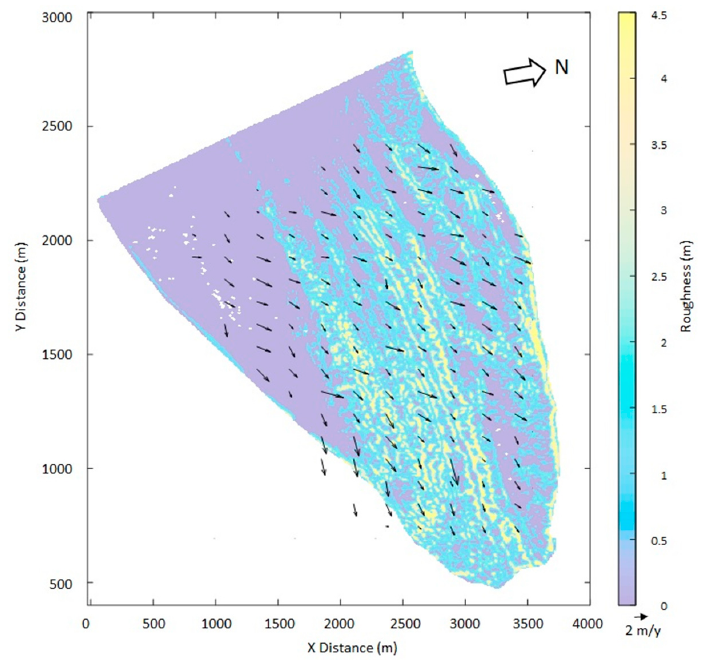
Figure 6. PIV derived surface flow field at the Taylor Glacier terminus overlaid on a map of surface roughness (average 1.7 m). The raw results were averaged over 200 m × 200 m regions.